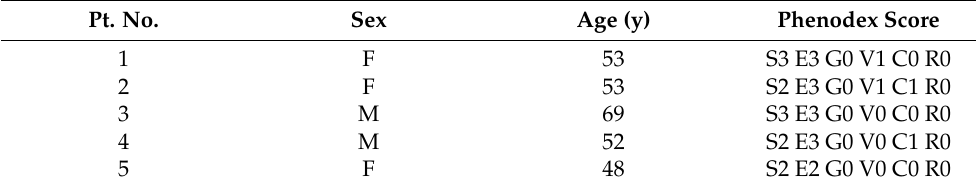
Table 1. Demographic data and Phenodex score of the PXE patients. Pt.